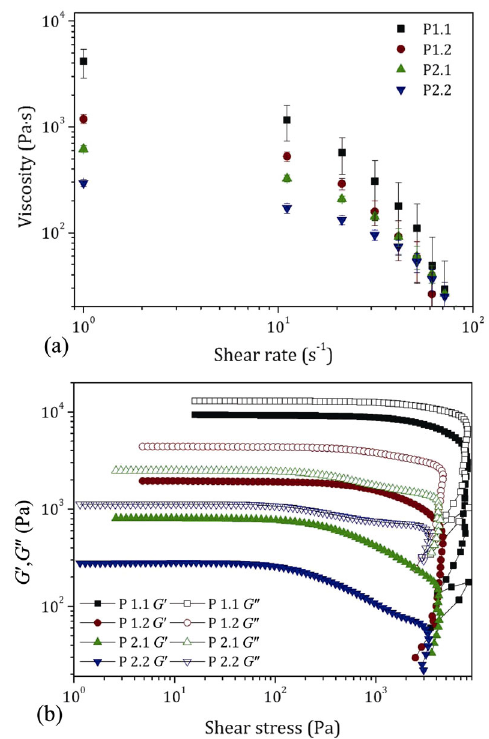
Fig. 2 (a) Viscosity vs. shear rate curves and (b) storage ( G ′ ) and loss ( G ″ ) modulus in function of the shear stress for the different paste